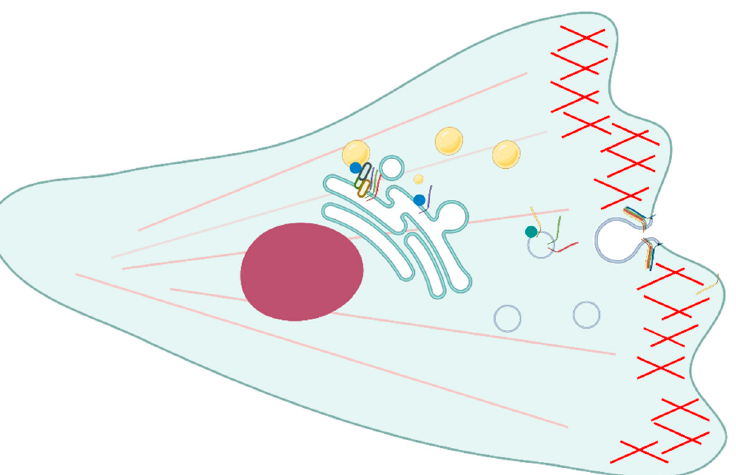
Figure 2. Scheme representing the interactions between Rab proteins and SNAREs during cell migra- tion in mammalian cells. At the plasma membrane, Rab11 (green spot)-positive vesicles containing syntaxin 4 (yellow bar) fuse after SNARE complex formation. This transport is in association with the regulation of actin cytoskeleton and cortical actin (short red filaments). Interestingly, at the ER (green compartment), Rab18 interacts with syntaxin 18 (violet bar) through the mediation of a protein complex in order to regulate the formation of lipid drops (yellow circles).